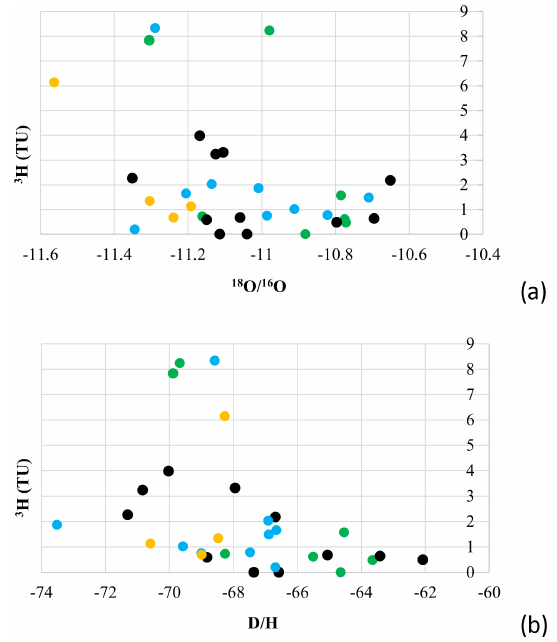
Figure 3. Correlation between (a) tritium and δ 18 O (expressed by the ratio 18 O / 16 O); (b) tritium and δ D (expressed by the ratio D / H) of each samples analysed. Coloured in green the samples form Quinto di Treviso, in black samples from Treviso, in light blue sam- ples from Preganziol and in yellow samples from